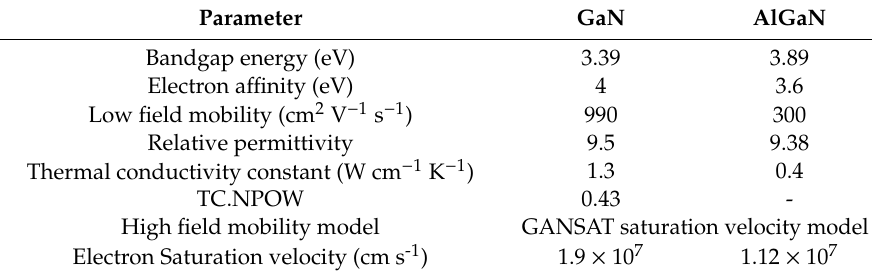
Table 2. Material parameters used for simulations at temperature 300